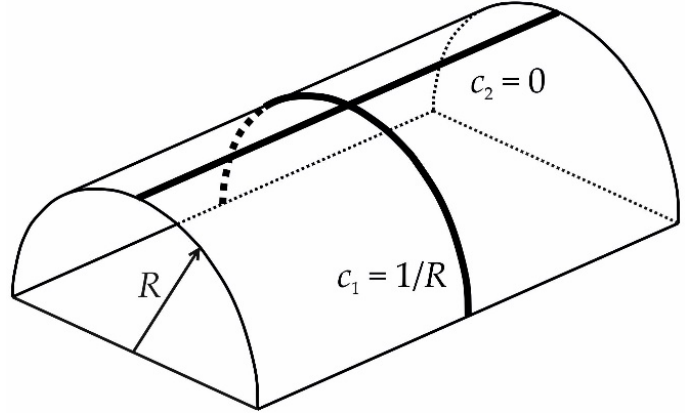
Figure 1. Illustration of the concept of the principal curvatures on the example of a cylindrical surface. The depicted half-cylinder of radius R has two principal directions: (1) along the circumference and (2) along the cylinder axis, which are perpendicular to each other. The corresponding principal curvatures are c 1 = 1/ R and c 2 = 0.